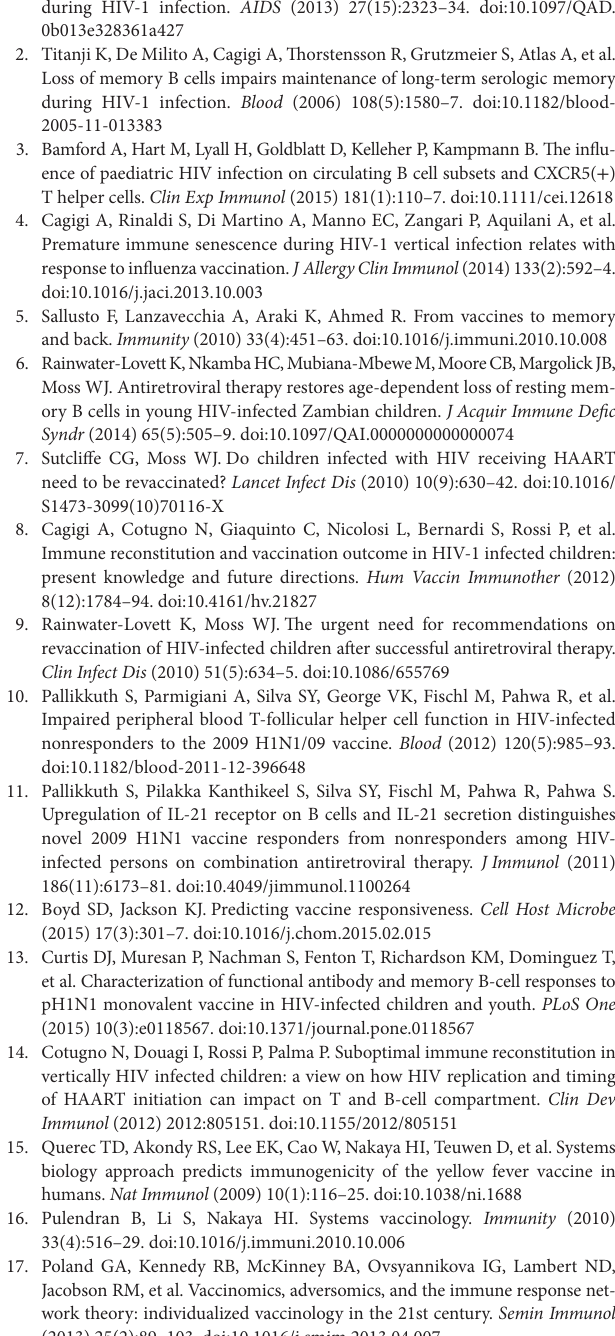
TaBle s3 | Differentially expressed genes between study groups. Note: genemania.org gene set enrichment analysis (GSEA) In every graph presented throughout the paper, circles with diagonal lines define genes included in the GSEA. Its function is described legend below the graph. The solid circles represent genes resulted to be involved in the pathways. Networks among the genes are defined by colored lines, further explained by